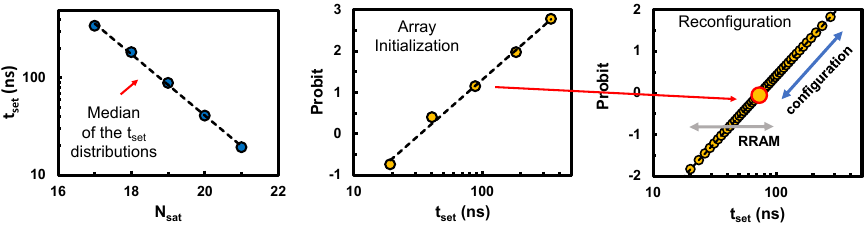
Figure 22: The median SET transition time (t set ) for different N sat values and the mapping to the probability of finding N sat (Figure 13) as shown in the middle figure. The median transition time is then used to construct the configuration-to-configuration transition time distribution for each RRAM elements used in the simulation as shown in the right